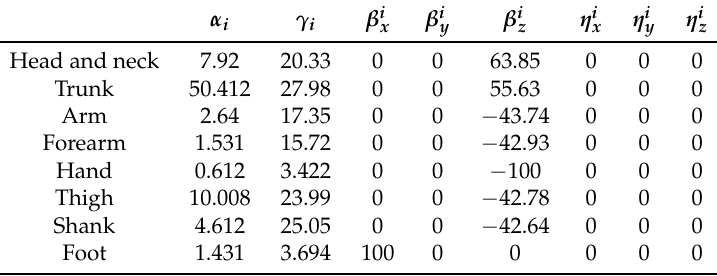
Table A2. Dempster model parameters for each body segment.